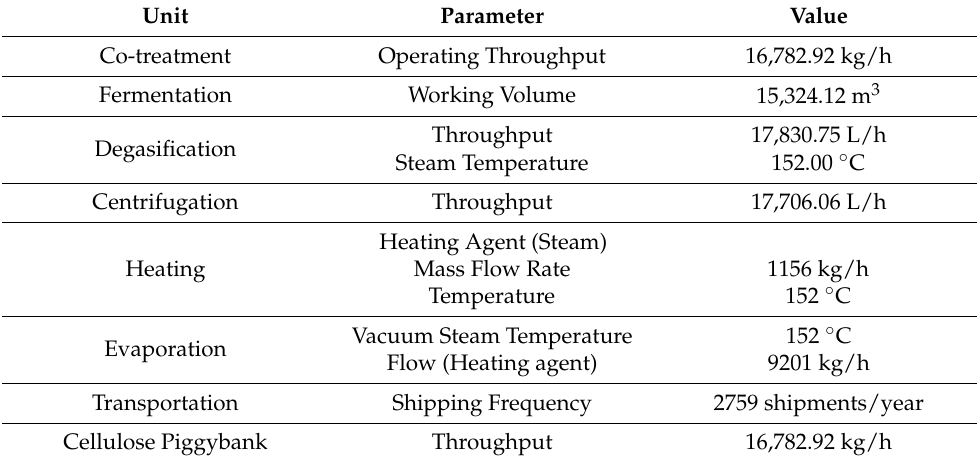
Table 5. Key performance parameters for the MixAlco